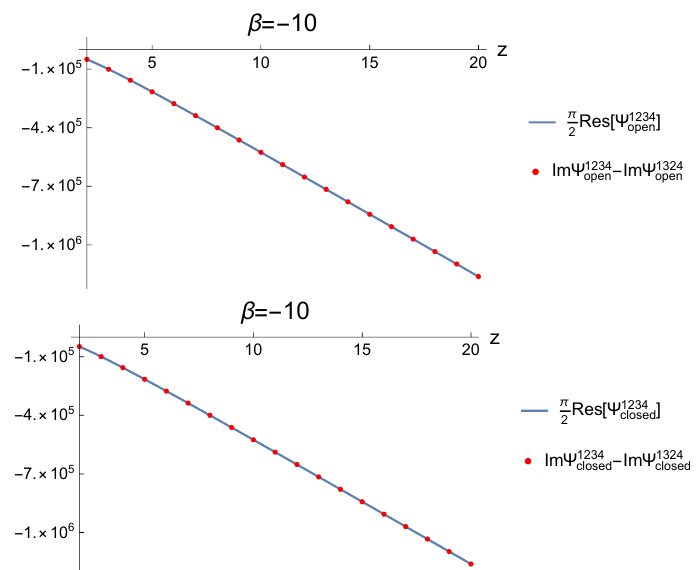
Figure 8: The comparison between the analytic formula for the residue at β = − 10 and the numerical evaluation of the imaginary part for the open and closed string celestial